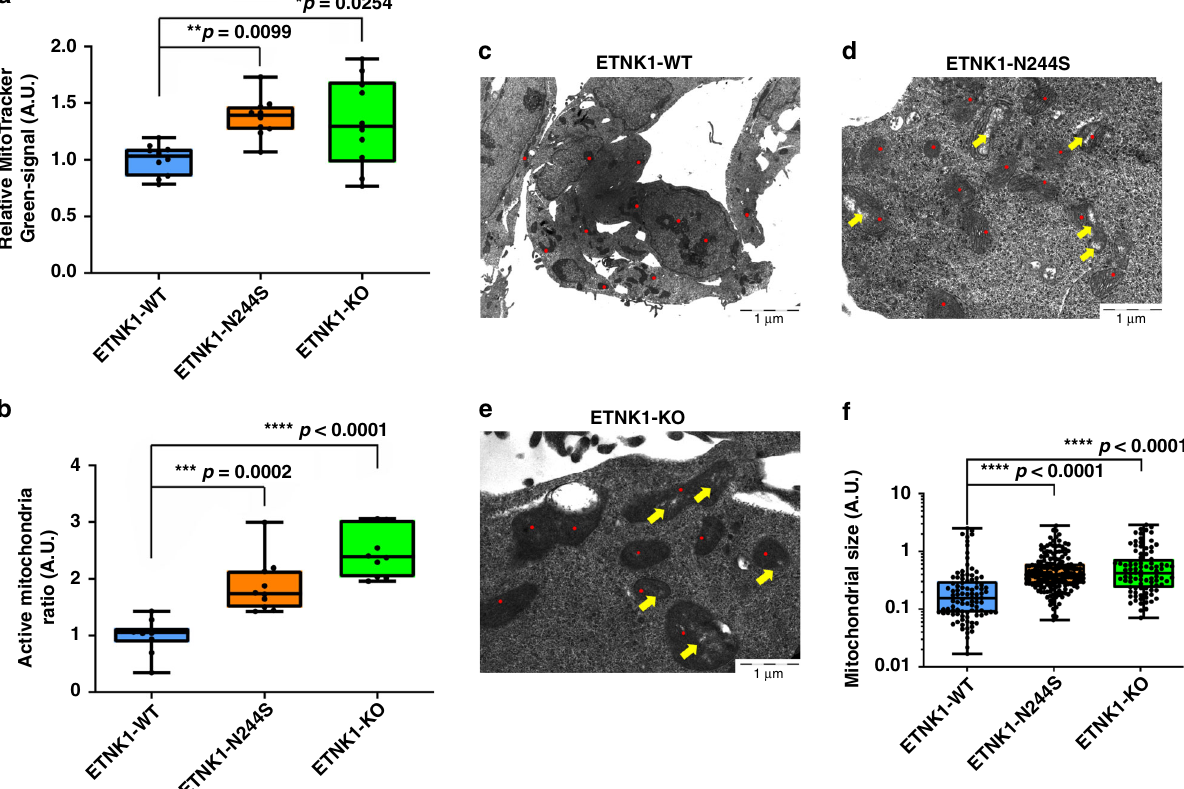
Fig. 1 Mitochondria morphology and activity. a Boxplots representing the MitoTracker Green analysis of ETNK1-WT, N244S, and KO CRISPR cell lines. Values represent relative units normalized on the ETNK1-WT signal. Statistical analyses were performed using one-way ANOVA with Tukey ’ s post-hoc test. The boxplots delimit the interquartile range; the central bar represents the median; the whiskers extend from minimum to maximum ( n = 10 representative fi elds). At least 200 cells were analyzed. b Boxplots showing the MitoTracker Red-to-Green signal ratio as assessed on ETNK1-WT, N244S, and KO CRISPR cell lines normalized on ETNK1-WT. Statistical analyses were performed using one-way ANOVA with Tukey ’ s post-hoc test. The boxplots delimit the interquartile range; the central bar represents the median; the whiskers extend from minimum to maximum ( n = 10 representative fi elds). At least 200 cells were analyzed. c – e Electron microscopy scans relative to ETNK1-WT c , N244S d , and KO e CRISPR cell lines. Red dots highlight the position of individual mitochondria. Yellow arrows point to low electron density areas. A total of 13 individual cells were analyzed. f Quanti fi cation of mitochondria size in ETNK1-WT, N244S, and KO CRISPR cell lines as assessed by electron microscopy. Statistical analyses were performed using one-way ANOVA with Tukey ’ s post-hoc test. The boxplots delimit the interquartile range; the central bar represents the median; the whiskers extend from minimum to maximum (ETNK1-WT: n = 96 representative fi elds; ETNK1-N244S: n = 172 representative fi elds; ETNK1-KO: n = 90 representative fi elds; the experiment was performed once). Source data are provided as a Source data fi